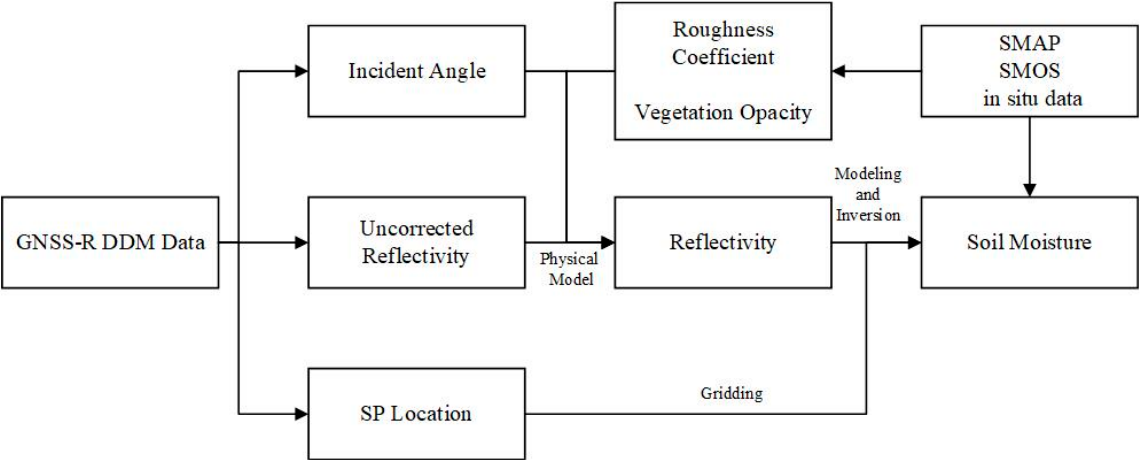
Figure 5. Spaceborne GNSS-R soil-moisture inversion flow-chart.